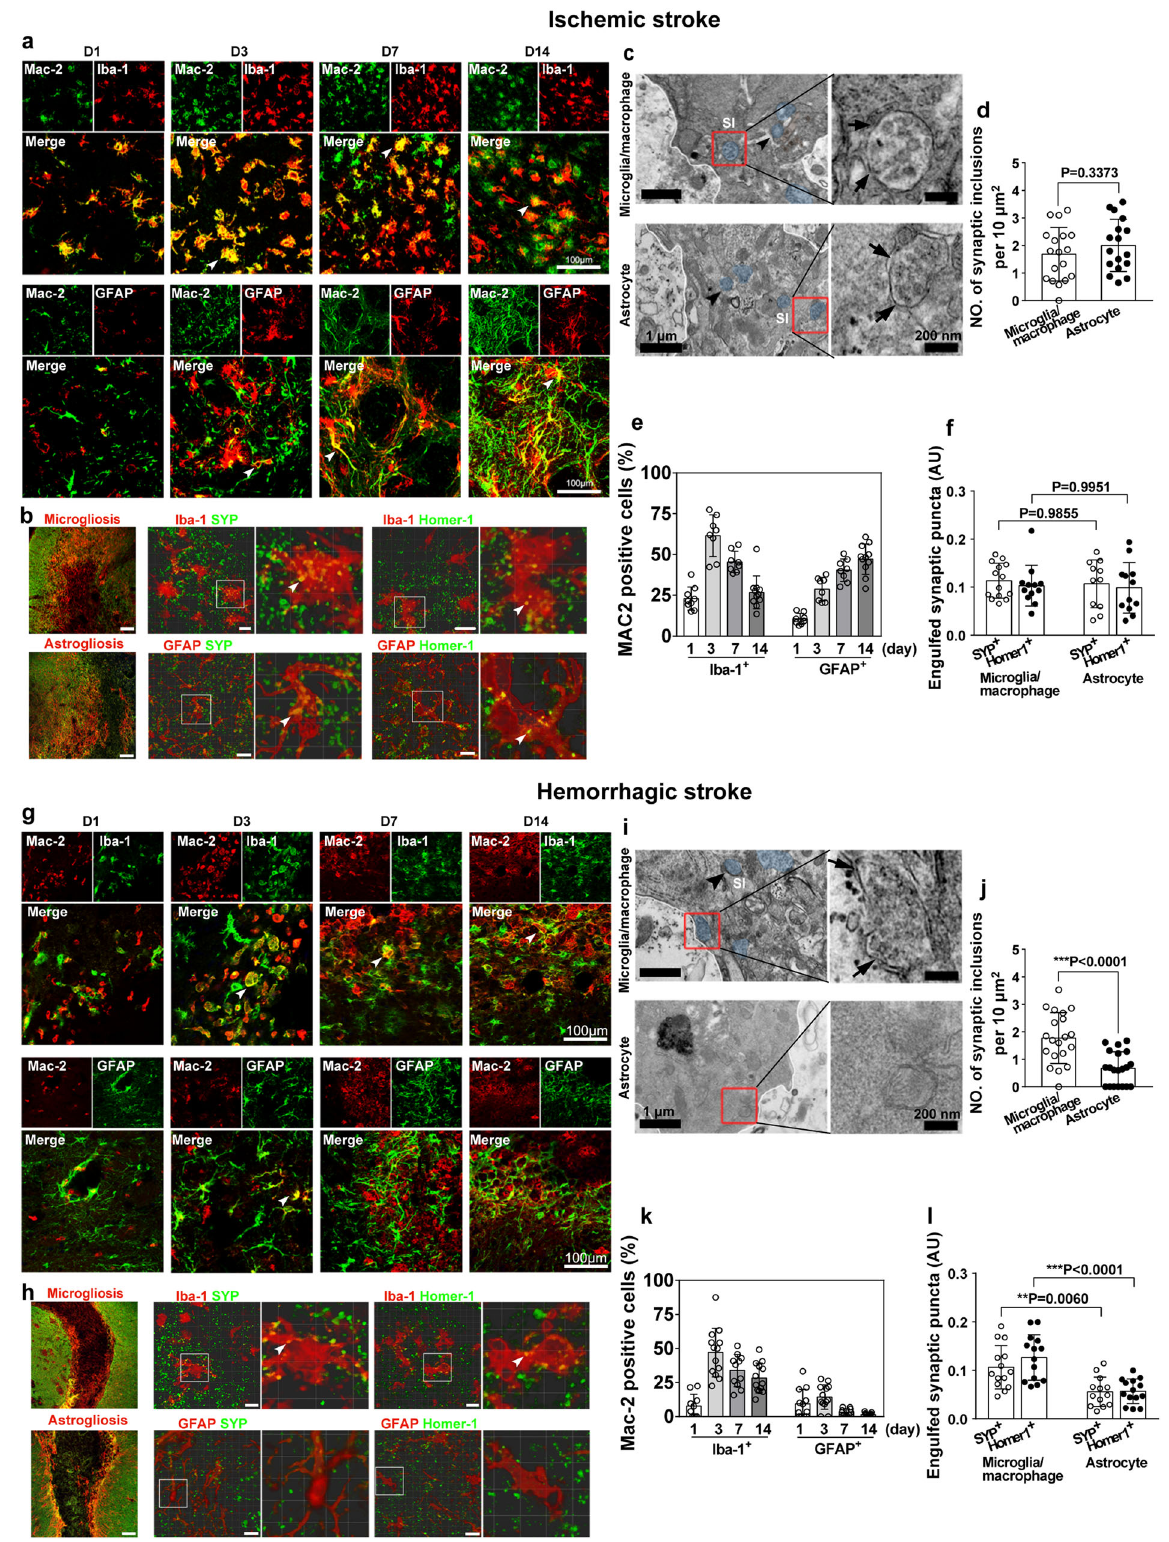
protection against synaptic excitatory/inhibitory imbalance (Fig. 2b, e). Detailed analysis of synaptic puncta inside the glial process showed that in the ischemic brain, the cellular or extra- cellular localization of mCherry-GFP and mCherry-alone puncta was similar in both microglia/macrophages and astrocytes (Fig. 2c, f). In the hemorrhagic brain, most of InhiPost